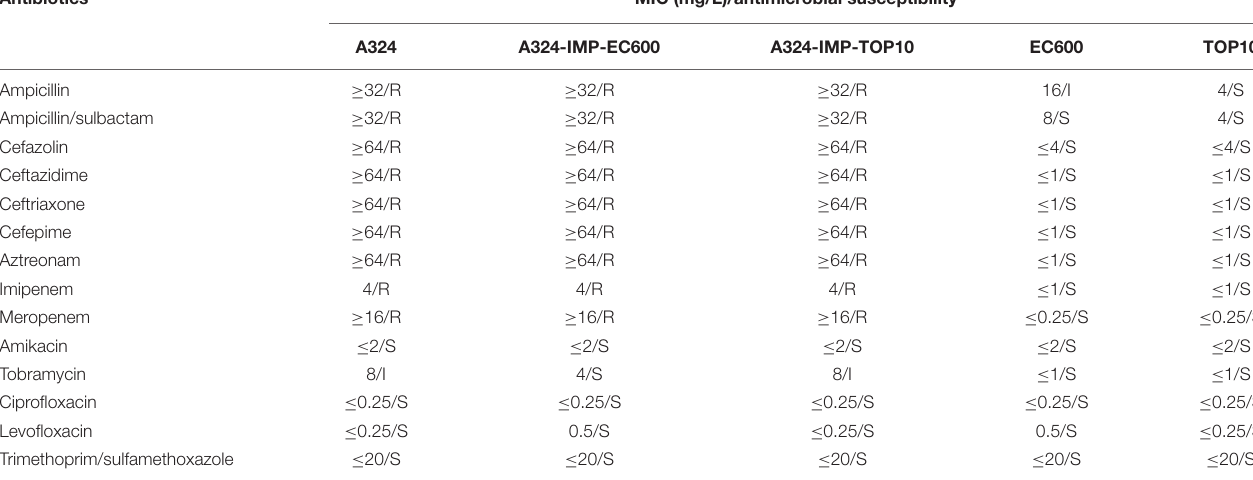
MIC (mg/L)/antimicrobial